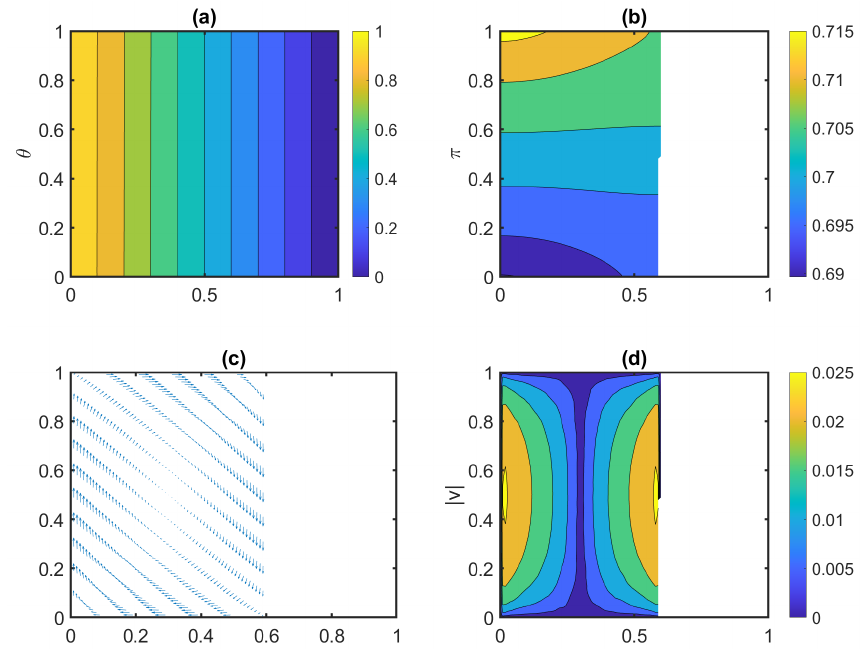
Figure 9. Initial condition of phase change material (PCM) cell: ( a ) contours of dimensionless temper- ature, ( b ) contours of dimensionless pressure, ( c ) velocity vector, ( d ) contours of velocity magnitude.